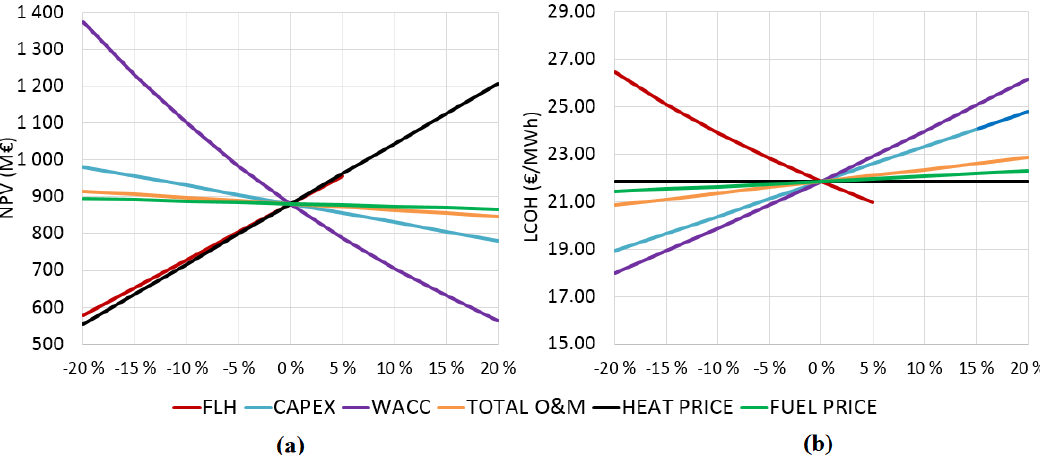
Figure 12. The NPV ( a ) and the LCOH ( b ) values from the sensitivity analysis performed on the SMR HOB.